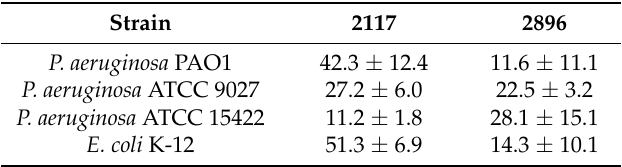
Table 3. Inhibitory activity of the leads (at 400 µM) on the transition from microcolonies to fully formed biofilms as quantified using crystal violet staining assay. Results are reported as mean ± SD of three independent experiments.